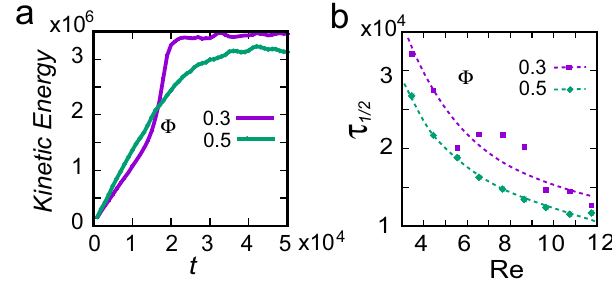
Fig. 8 Time evolution of the kinetic energy of the system. a Temporal change of the total kinetic energy for off-symmetric ( Φ = 0.3) and symmetric ( Φ = 0.5) cases at Re = 10.8. The steep increase in Φ = 0.3 is associated with droplet compaction accompanying hexatic ordering. b Re- dependence for the time at which the kinetic energy reaches half its fi nal value, τ 1/2 , for Φ = 0.3 and 0.5. The dashed curves are guides to